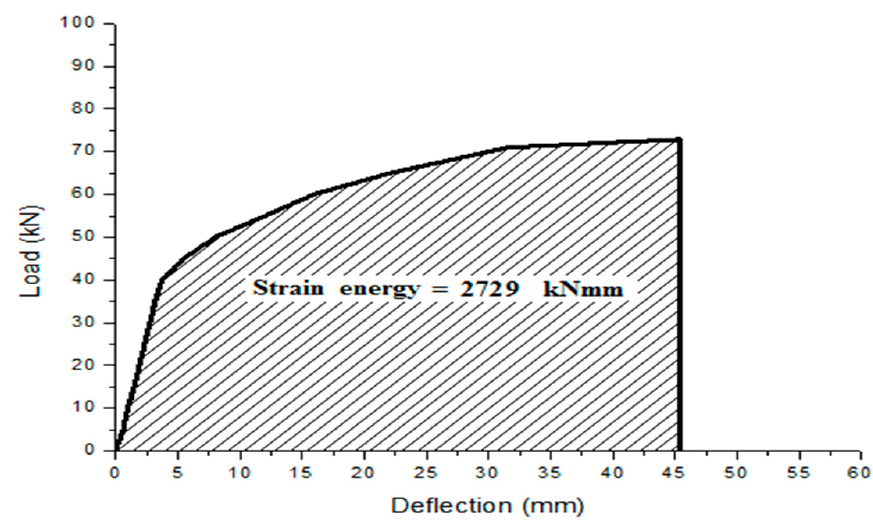
Figure 16. Strain energy for trapezoidal profiled composite slab—Trial I.